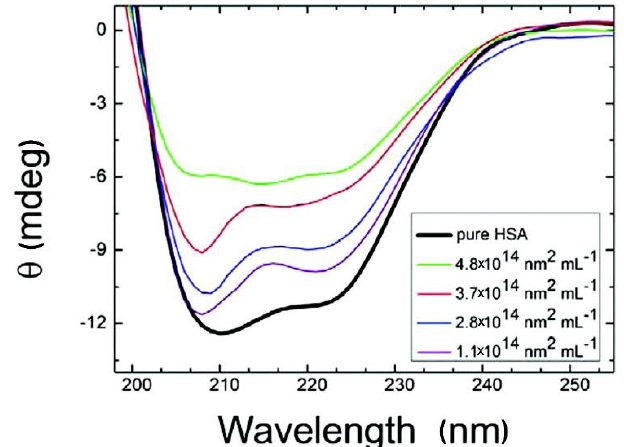
Figure 7. Circular dichroism (CD) spectra of HSA with citrate-stabilized silver NPs (diameter, 36 nm, with NP surface site concentrations ranging from 1.1 × 10 14 to 4.8 × 10 14 nm 2 · mL − 1 ). Reprinted with permission from [99]. Copyright (2012) American Chemical Society.